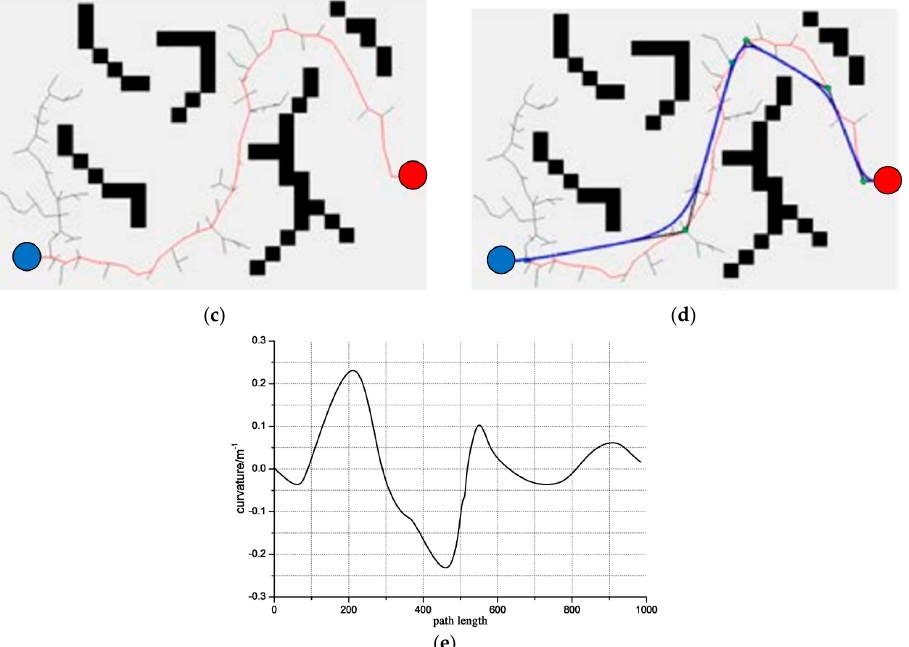
Figure 2. Comparison of the three algorithms and the result of the Smoothly Rapidly Exploring Random Tree (S-RRT) algorithm. ( a ) Random tree with Basic-RRT; ( b ) Random tree with Bi-RRT; ( c ) Random tree with S-RRT; ( d ) Random tree with optimized S-RRT; ( e ) Curvature variation map of the path generated by S-RRT. Table 1. Simulation comparison result of different algorithms.